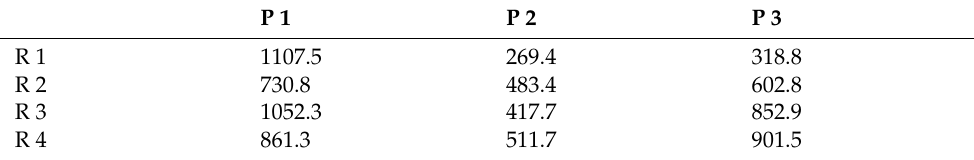
Table A7. Distance between recycling center R and waste treatment center P (km).